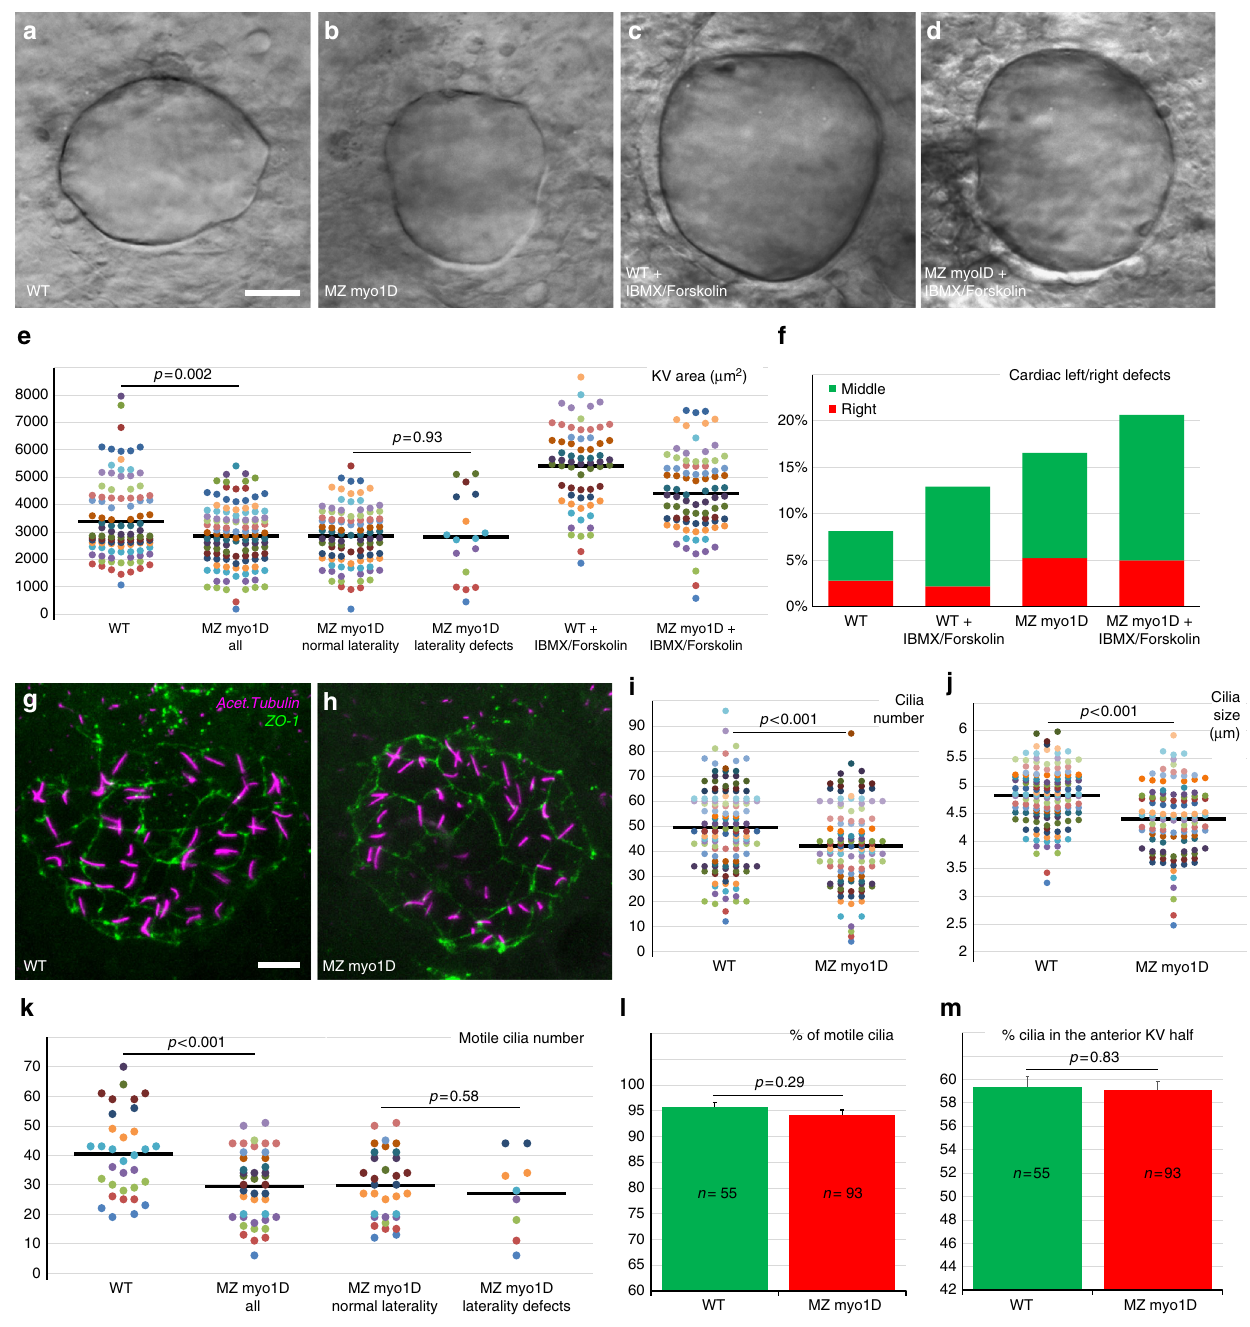
Fig. 3 myo1D controls the morphogenesis of the zebra fi sh left – right Organizer. a – e Compared to WT ( n = 104), MZ myo1D mutants ( n = 118) present a reduced KV size. Treatment with IBMX and Forskolin promotes KV lumen in fl ation and increases organ size in WT ( n = 66) and MZ myo1D mutants ( n = 85). e Dot plots of KV equatorial surface area in individual embryos. KV size is similar in embryos with normal or defective laterality. f IBMX/Forskolin treatment restores KV size ( d , e ), but not laterality in MZ myo1D mutants. g – j Cilia number and size are reduced in MZ myo1D mutants. g , h Projection of images from confocal stacks used to quantify number and length of cilia (acetylated tubulin, magenta) in the KV (ZO-1 positive cells, green). i , j Number and average length of cilia in individual embryos are reduced in MZ myo1D ( n = 117 embryos/4939 cilia) compared to WT ( n = 141/6967). k – m Confocal imaging of Arl13b-GFP labeled cilia in living embryos was used to analyze the number ( k ), motility ( l ) and positioning ( m ) of KV cilia. k Dot plot representing motile cilia number in individual embryos. MZ myo1D ( n = 42) mutants display lower motile cilia numbers compared to WT ( n = 33). Motile cilia numbers are however similar in MZ myo1D mutant embryos with normal or defective laterality. Total cilia numbers for this experiment are displayed in Supplementary Fig. 5. l myo1D loss of function does not impair ciliary motility. m WT and MZ myo1D mutant animals display a similar enrichment of cilia in the anterior KV half. a – d , g , h are dorsal views of the KV, anterior up. All data collected at the eight-somites stage. Horizontal bars in e , i , j , k represent mean values. Error bars in l , m represent SEM. Scale bars: 20 µ m in a – d ; 10 µ m in g –